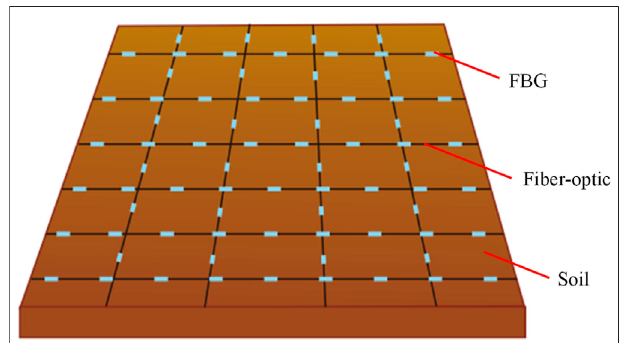
FIGURE 2 | Schematic diagram of FBG quasi-distributed monitoring of soil water